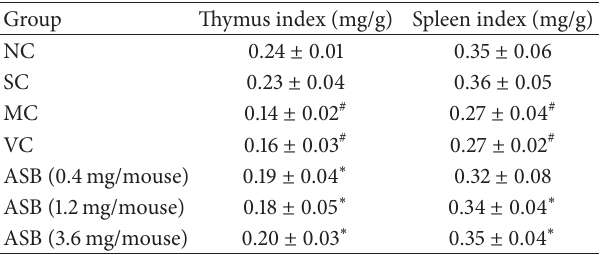
Table 1: Effects of ASB on thymus index and spleen index on photoaged mice